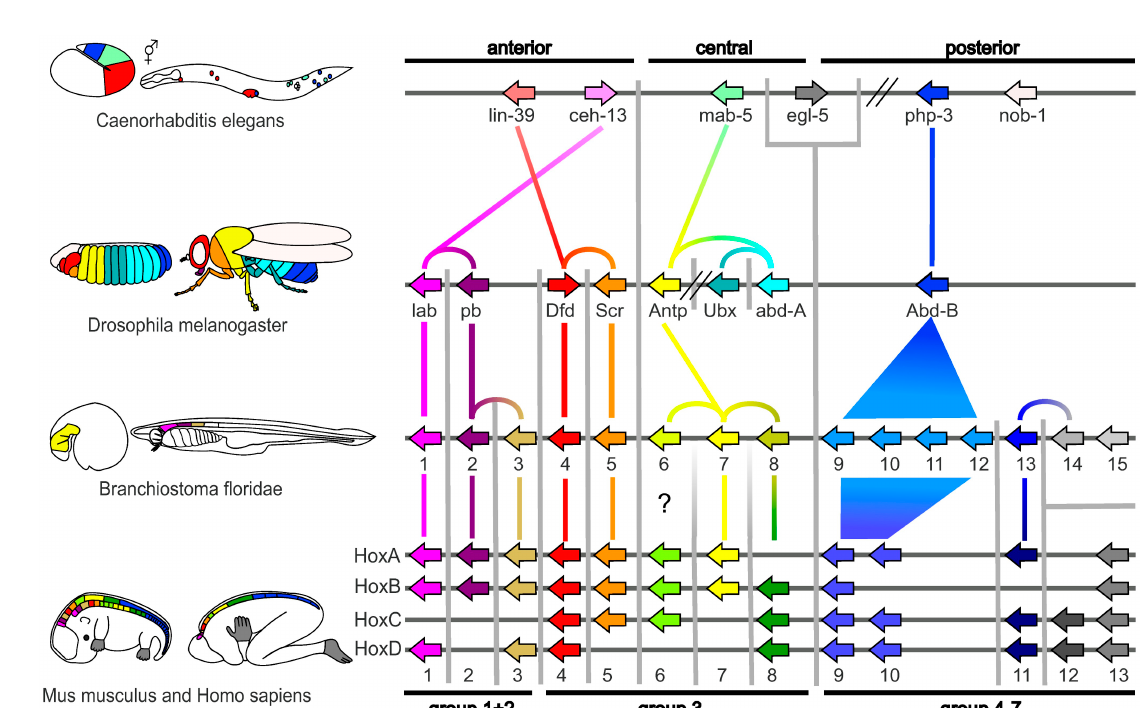
Figure 3. Scheme showing how homologous hox genes control embryonic development and hence the form of adult bodies [77].